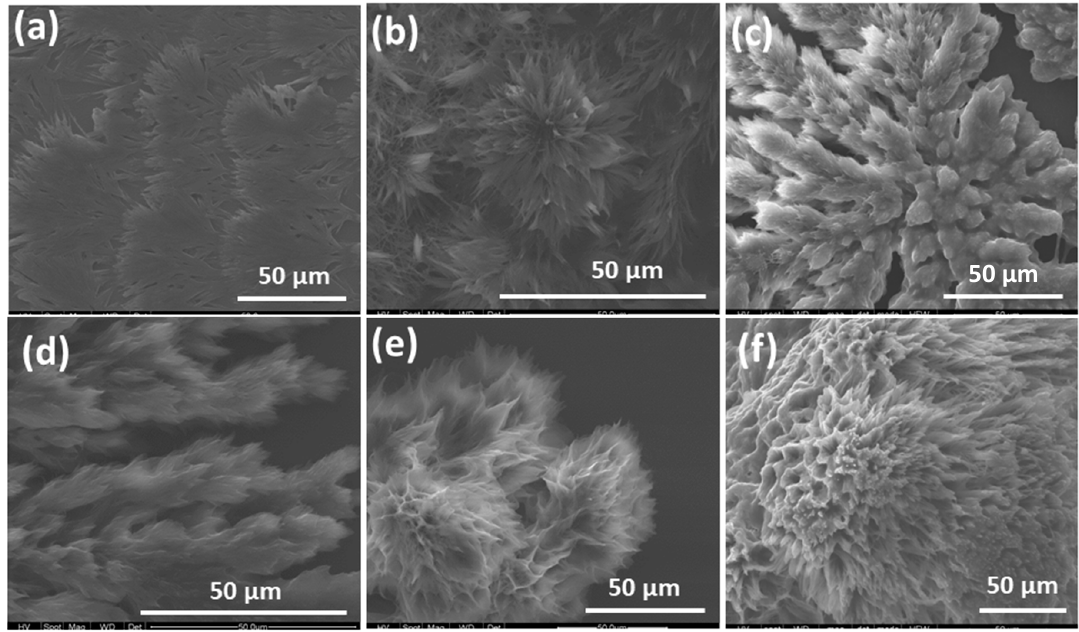
Figure 3. SEM images of self-assembled PPIX with ( a ) 1 equiv. D -arginine, ( b ) 4 equiv. D -arginine, ( c ) 16 equiv. D -arginine, ( d ) 1 equiv. L -arginine, ( e ) 4 equiv. L -arginine and ( f ) 16 equiv. L -arginine.